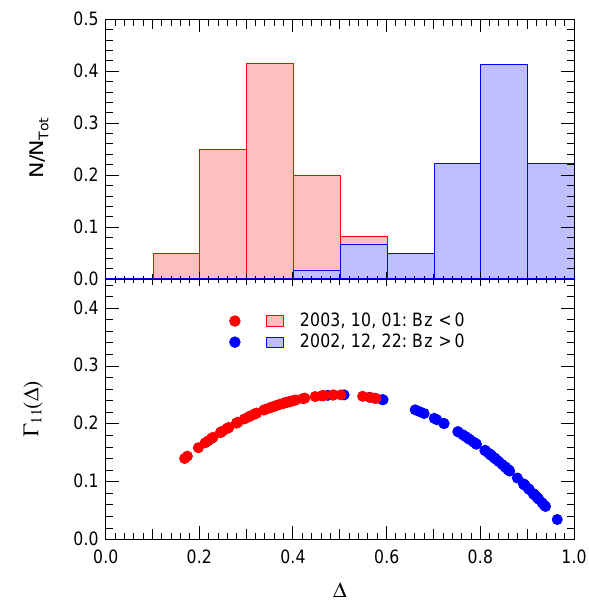
Fig. 3. Top panel: histograms of the normalised disorder degree 1 , in 0.1 bins, for the 1 October 2003, 19:30–21:30UT (IMF B z < 0, red cityscape) and 22 December 2002, 14:00–16:00UT (IMF B z > 0, blue cityscape) intervals; the values of each histogram have been normalised to the total number of scans (which is 60 for both). Bottom panel: second order complexity measure 0 11 as a function of the normalised disorder degree 1 for the same time in- tervals (IMF B z < 0: red dots; IMF B z > 0: blue dots).